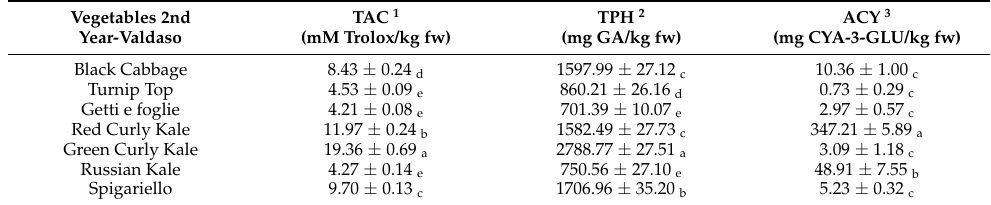
Table 7. Phenolics, anthocyanins contents and antioxidant capacity in the different type of vegetables analyzed during 2nd year in Valdaso.